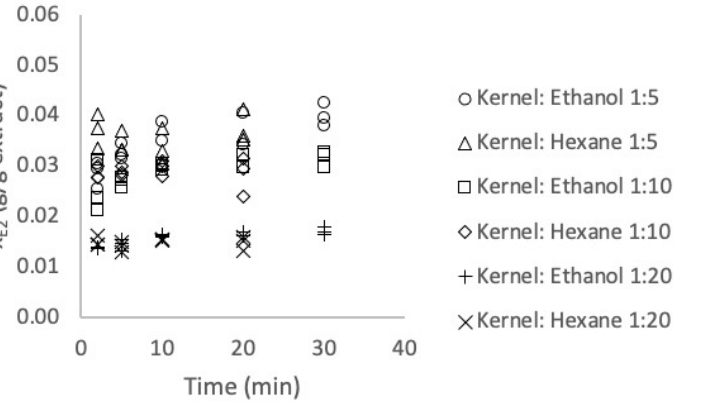
Figure 2. Extract concentrations vs. time in kernel feed extraction at 50 °C (<0.85 mm particle size).